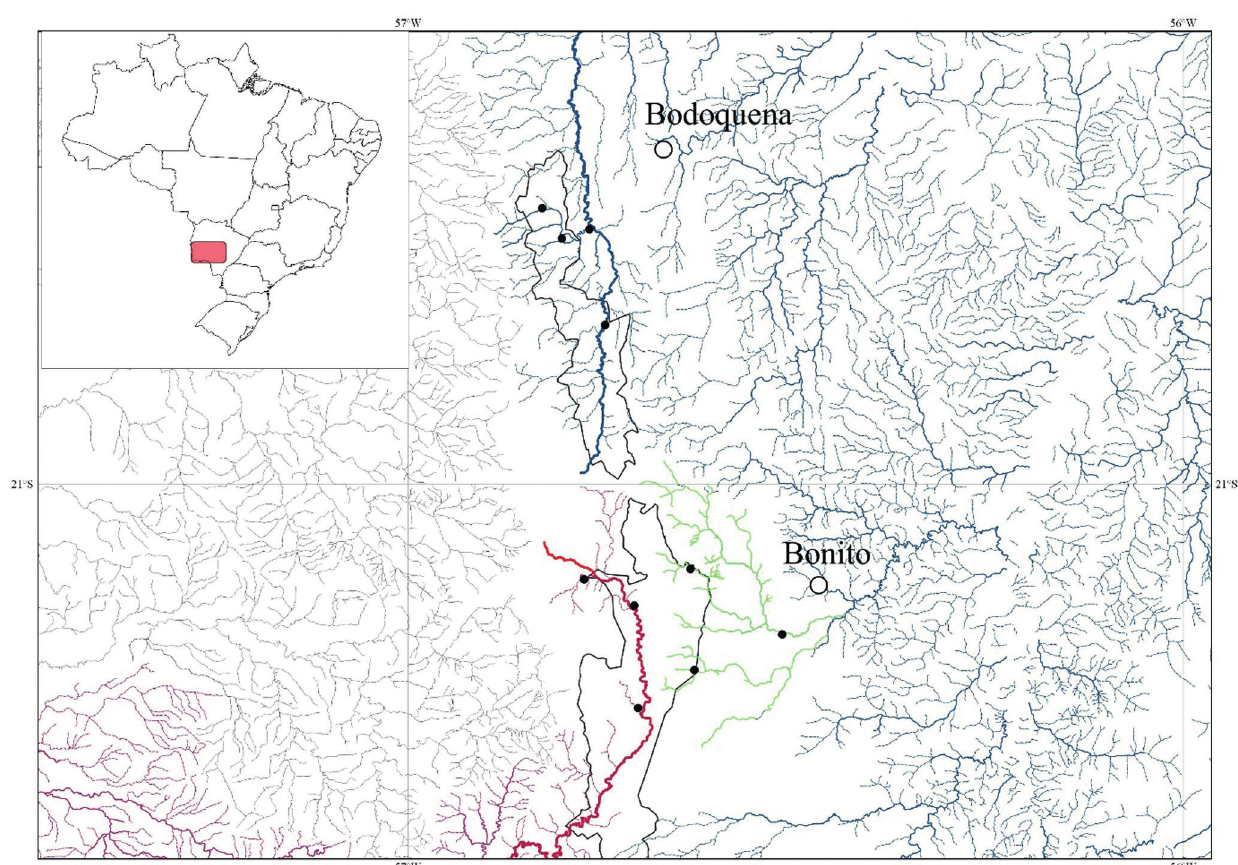
FIGURE 1 | Main drainages of Serra da Bodoquena. The Miranda River watershed (blue) and the Perdido River watershed (red). Highlighted lines represent Salobra River in the North and Perdido River in the South. In green, the Formoso River watershed, a tributary of Miranda drainage. Black dots represent the points of underwater observations of the fish